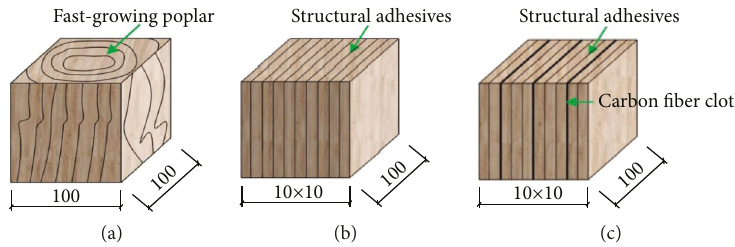
Figure 1: Layout of the specimens: (a) Y 1, (b) X 1, and (c) A 1-5 and B 1-2.